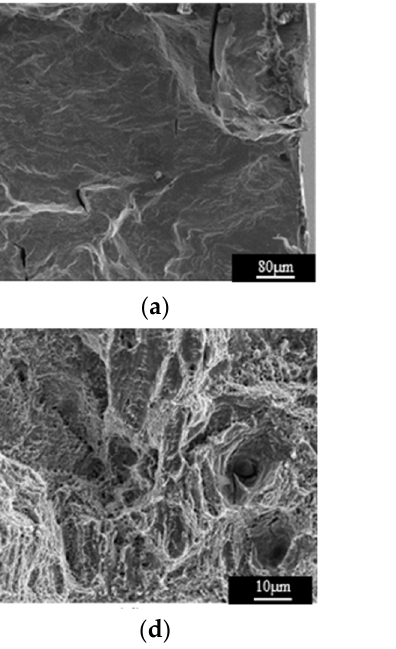
Figure 9. The SLM 316L stainless steel specimens (C1 to C6).